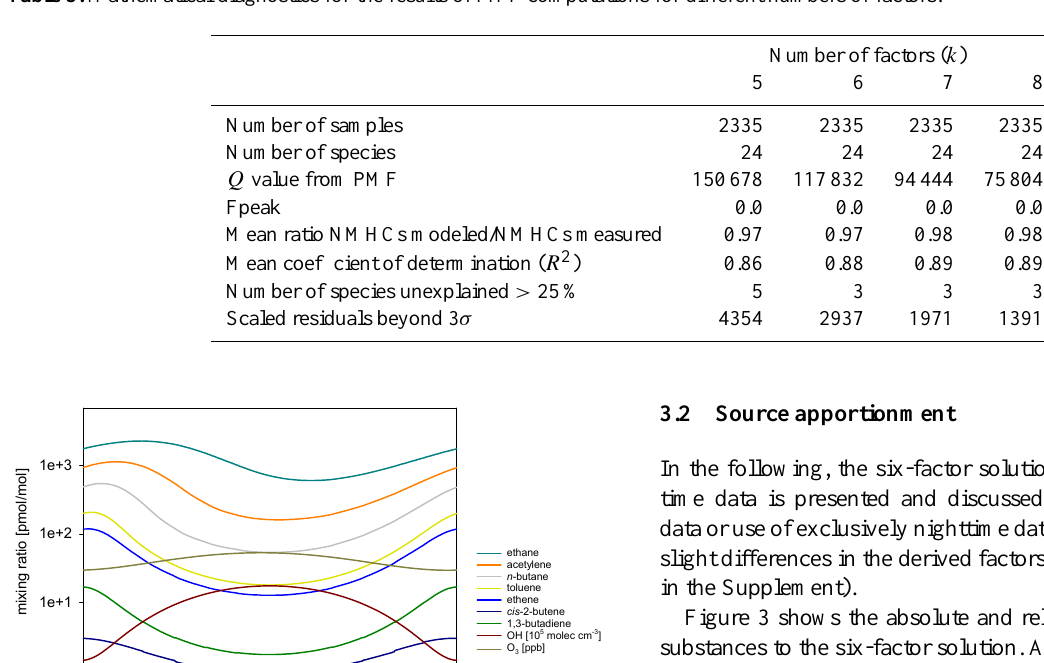
Table 3. Mathematical diagnostics for the results of PMF computations for different numbers of factors.